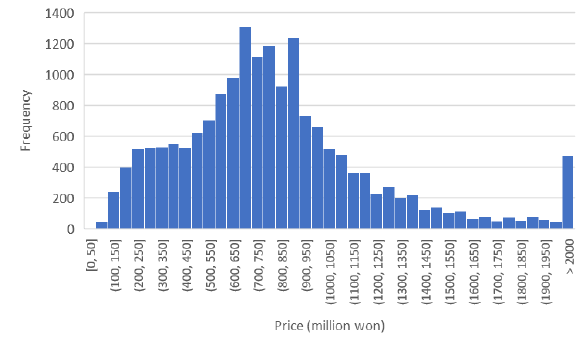
Figure 2. Histogram of traded apartment